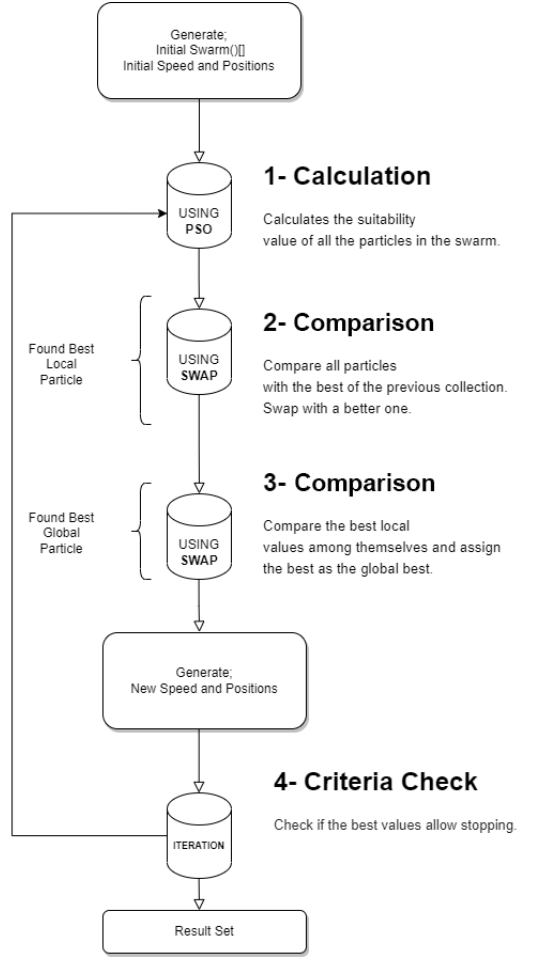
Figure 2. Flow Chart of PSO